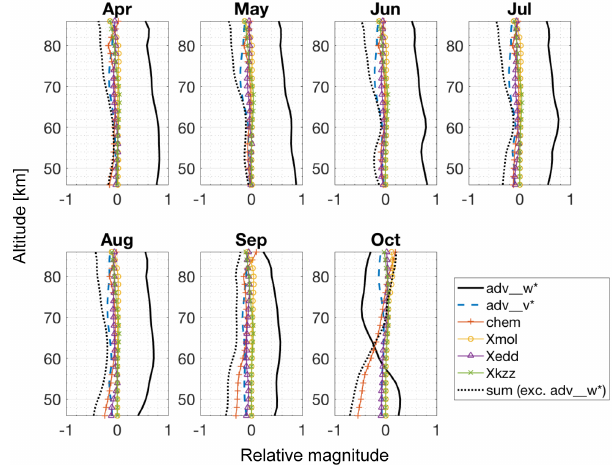
Figure 9. North polar average (60–90 ◦ N) monthly mean CO ten- dencies (see Eq. 2) around winter time, calculated using SD- WACCM output from January 2008 to April 2014. Model output corresponding to 10 days directly before and after a SSW, as well as the start date, is excluded. The values are expressed relative to the monthly means of the sum of the absolute values of all tenden- cies at a given altitude, and are referred to as relative strengths (see Sect. 5). A relative strength of the sum of the tendencies, excluding adv_ w ∗ , is also plotted.